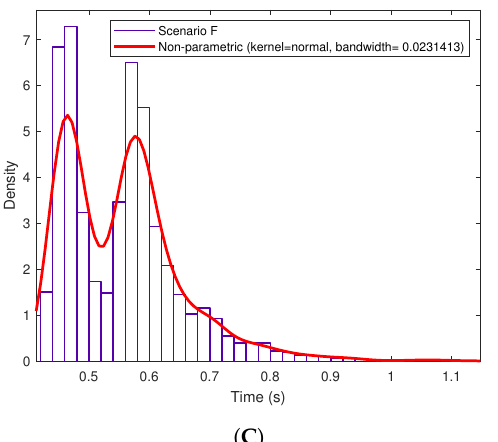
Figure 16. Probability Density Function (pdf) in OrbitDB for ( A ) Scenario D, ( B ) Scenario E and ( C ) Scenario F.